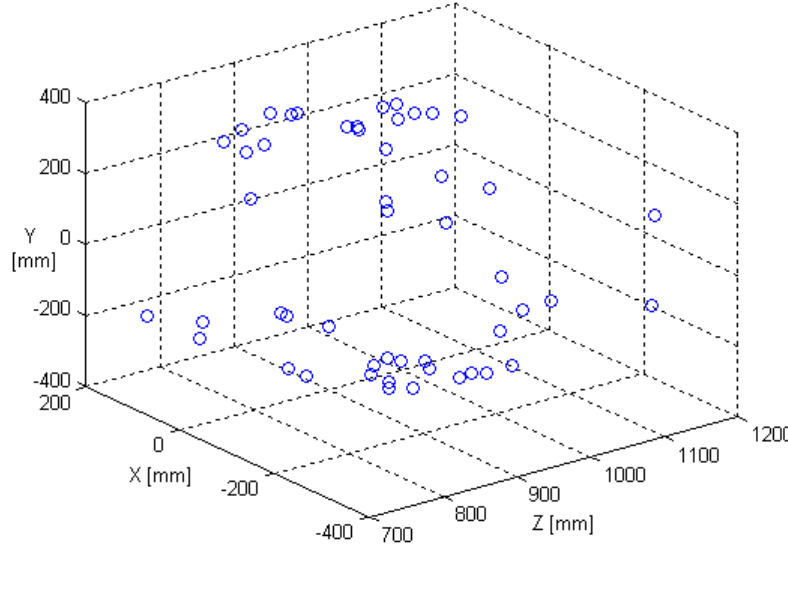
Figure 3. A synthesized cloud of fifty 3D